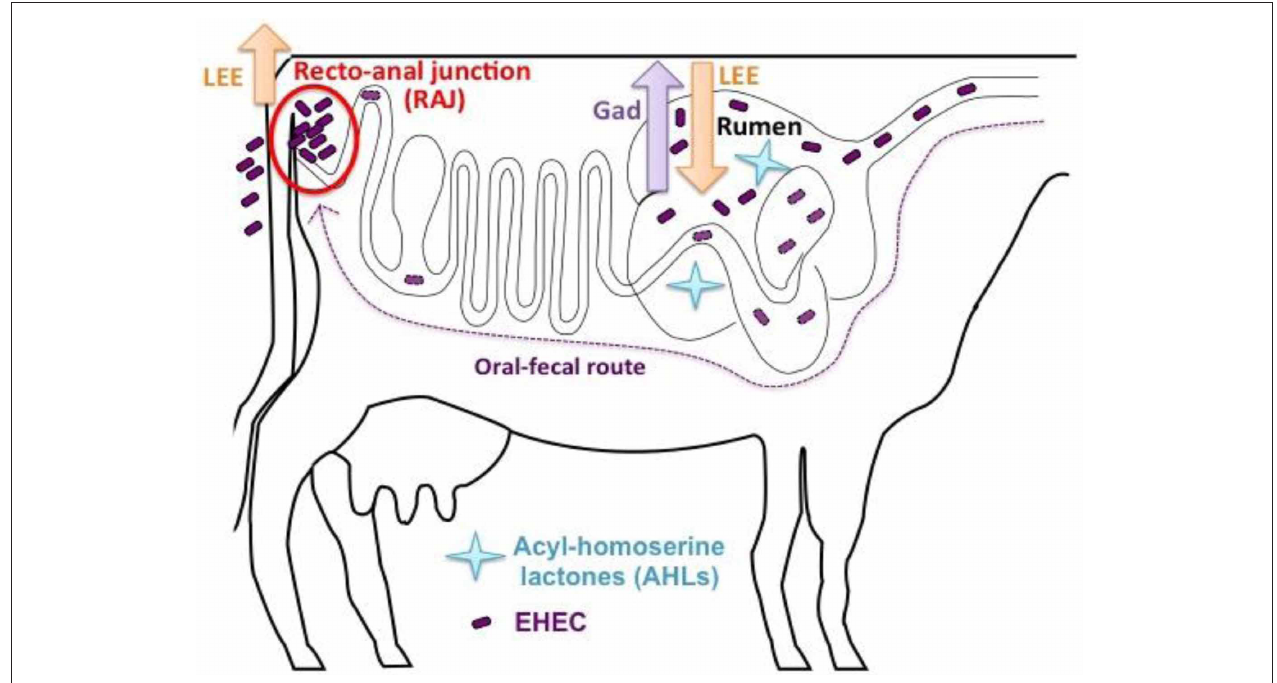
FIGURE 2 | Proposed EHEC SdiA-AHL signaling in